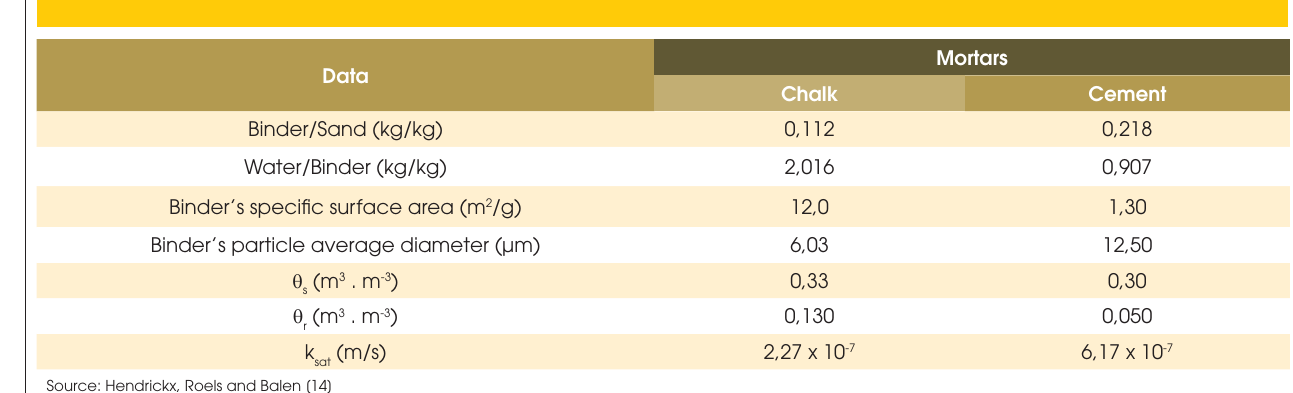
Table7 – Composition, properties and parameters of suction for mortars manufactured from chalk or